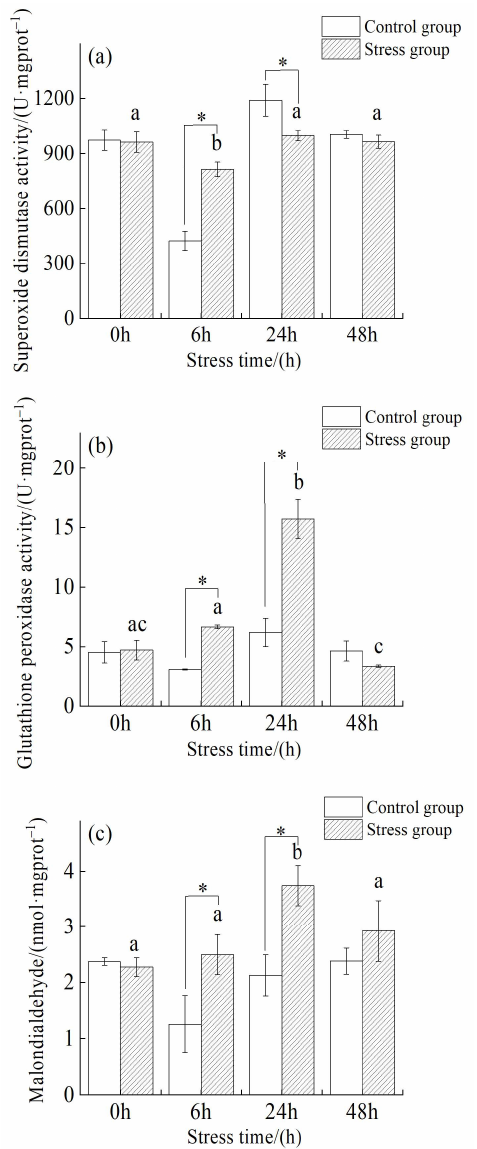
Figure 4. Effect of acute low salt stress on the antioxidation of red muscle of juvenile yellowfin fish ( Thunnus albacares ), ( n = 9) . ( a ), Superoxide dismutase activity; ( b ), Glutathione peroxidase activity; ( c ), Malondialdehyde. Different letters indicate the difference between the experimental group and the control group over time, and * indicates the difference between the experimental group and the control group.